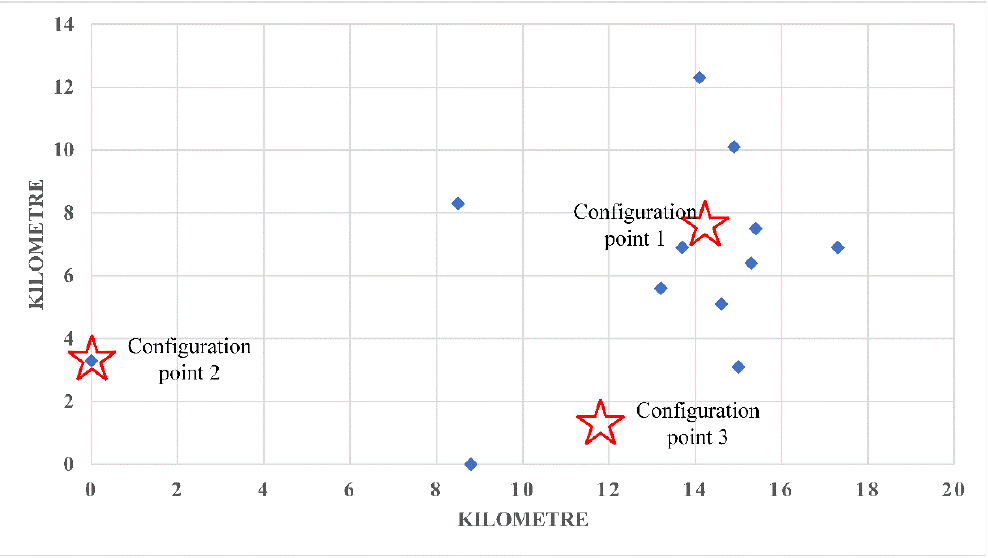
Figure 10. Distribution map of resource allocation points in